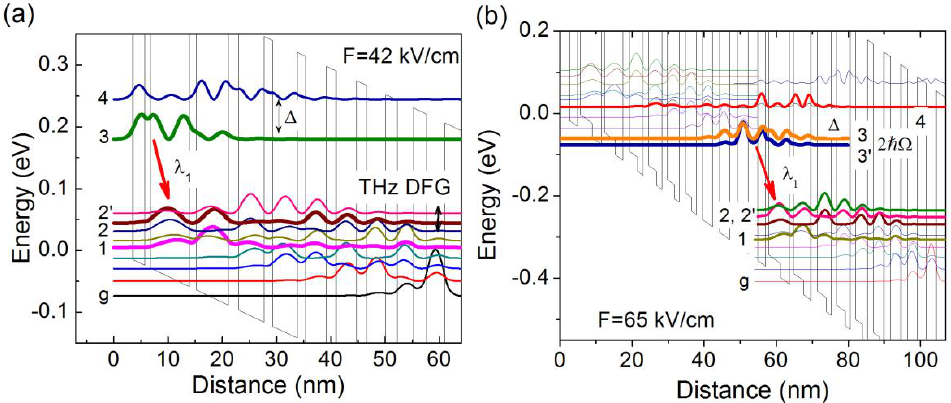
Figure 2. ( a ) Band structure of a SPR structure at λ ~ 9 µm with large nonlinear DFG susceptibility based on a lattice-matched Ga 0.47 In 0.53 As/Al 0.48 In 0.52 As material system; and ( b ) band structure of a strongly-coupled SPR structure at λ ~ 7.8 µm based on a strain-balanced Al 0.63 In 0.37 As/Ga 0.35 In 0.65 As/Ga 0.47 In 0.53 As material system.